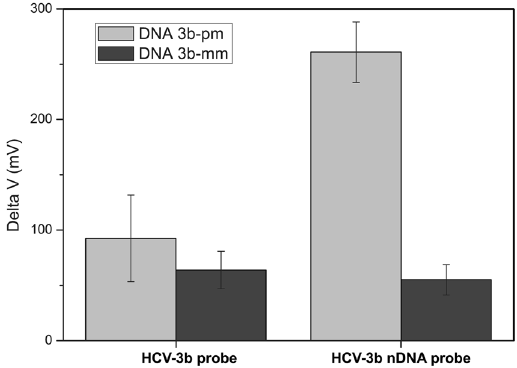
Figure 4. Enhanced SNP discrimination of the probe via SiNW FET measurements in 10 mM BTP buffer and at 40 °C. Quantitative data of gate voltage changes exhibit the operation conditions are benefit for the HCV-3b nDNA probe, and a significant difference is found between the average signals generated by matched and mismatched